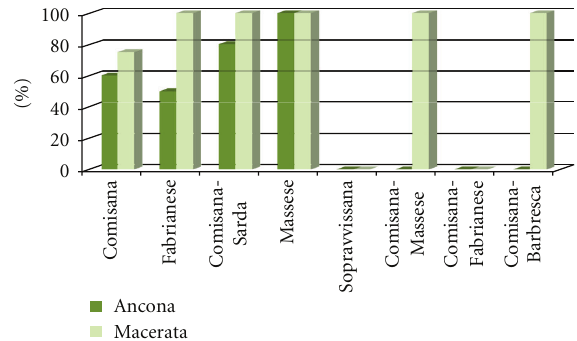
Figure 3: Herd seroprevalence of MAP in relation to ovine breeds in Ancona and Macerata provinces.